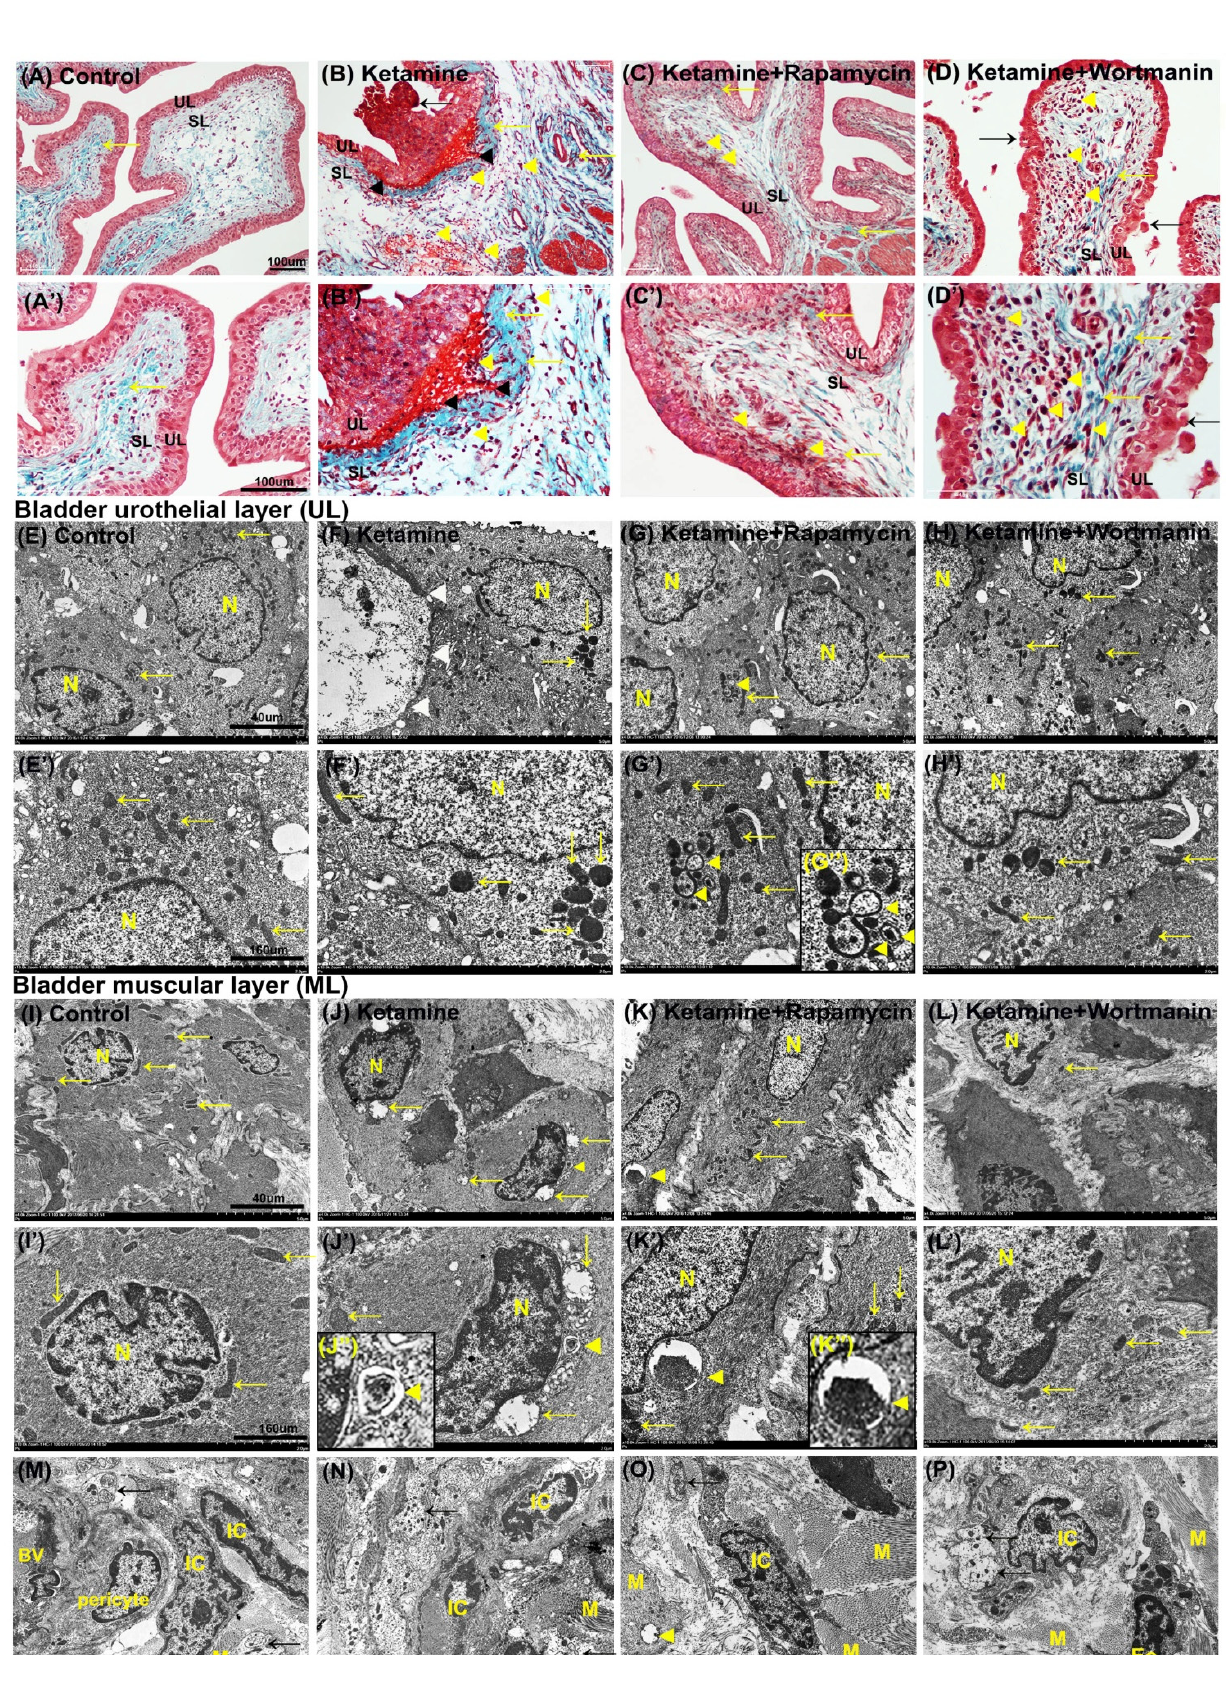
Figure 3. Histopathological examination for bladder damage as shown by Masson’s trichrome staining and ultrastructure observation detected by transmission electron microscope (TEM). ( A – D , A’ – D’ ) The bladder pathological features of the control group ( A , A’ ), the ketamine group ( B , B’ ), the ketamine+rapamycin group ( C , C’ ), and the ketamine+wortmannin group ( D , D’ ). Masson’s trichrome stain showed the blue-stained collagen, and the red-counterstained DSM highlighted